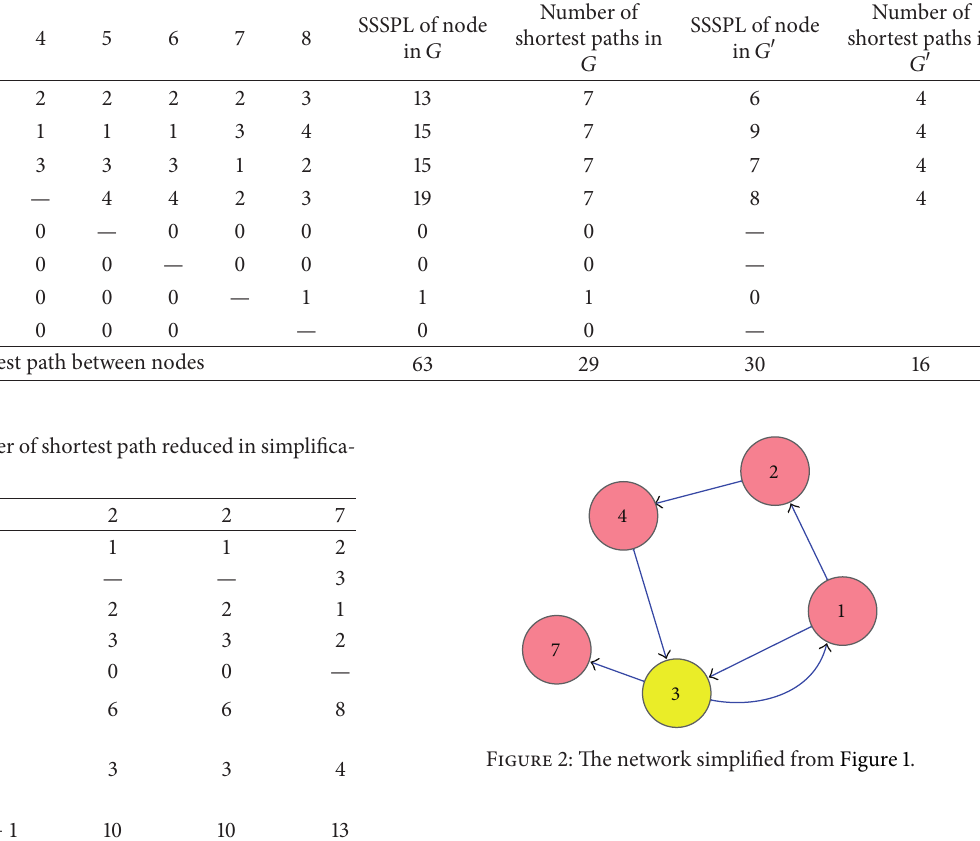
Table 1: The SSSPL of each node and the ASPL of the original and simplified networks.